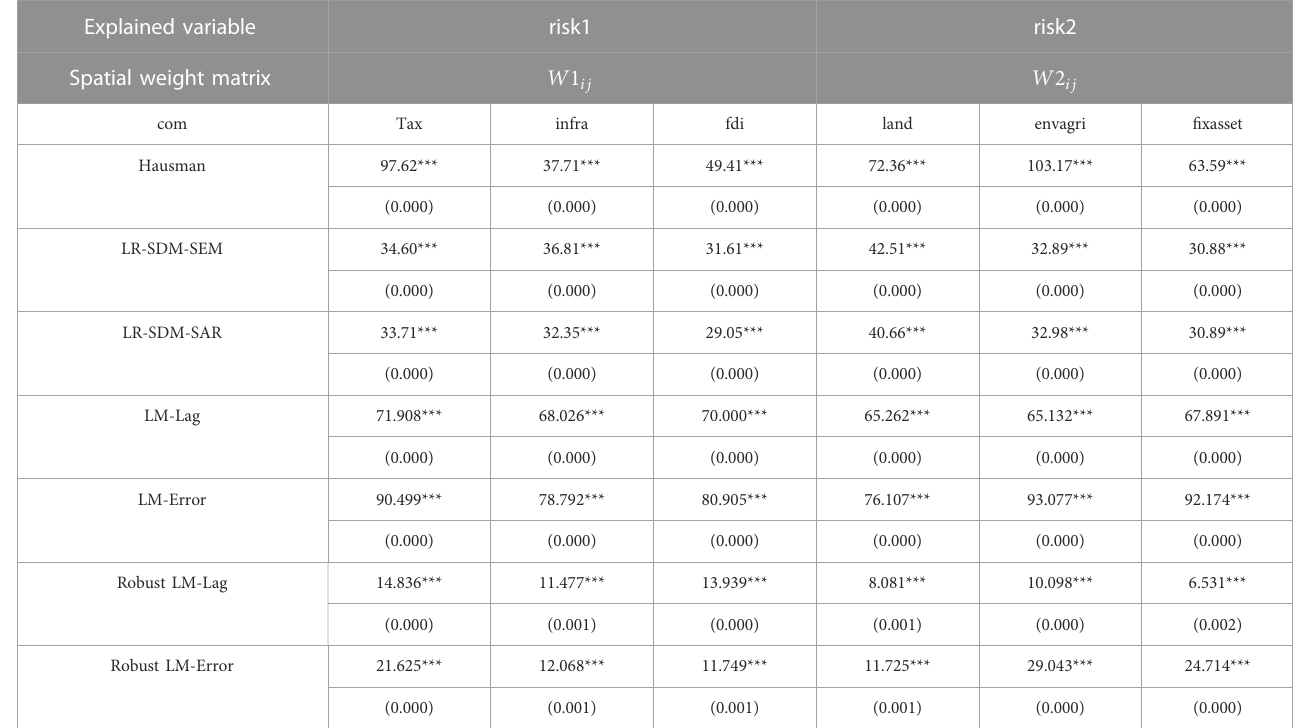
TABLE 4 The results of model